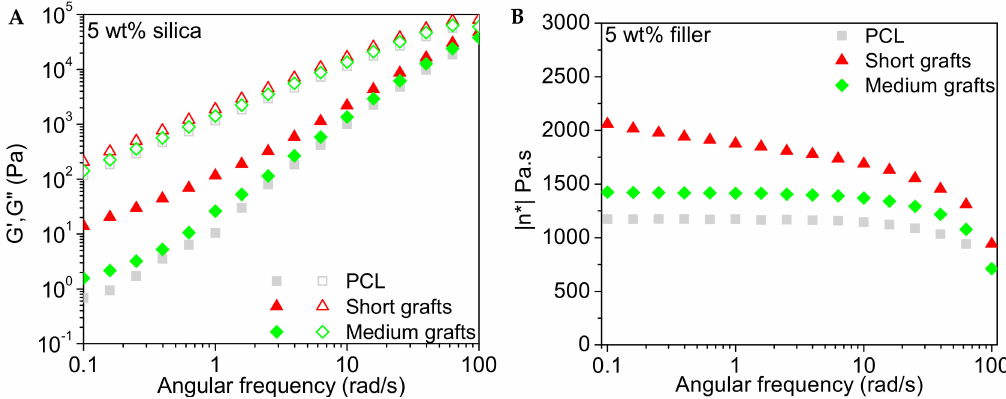
Figure 13. Storage and loss modulus ( A ) and complex viscosity ( B ) as a function of angular frequency for di ff erent PCL / silica composites based on the PCL40 matrix and 5 wt% filler. Measurements were performed at 60 ◦